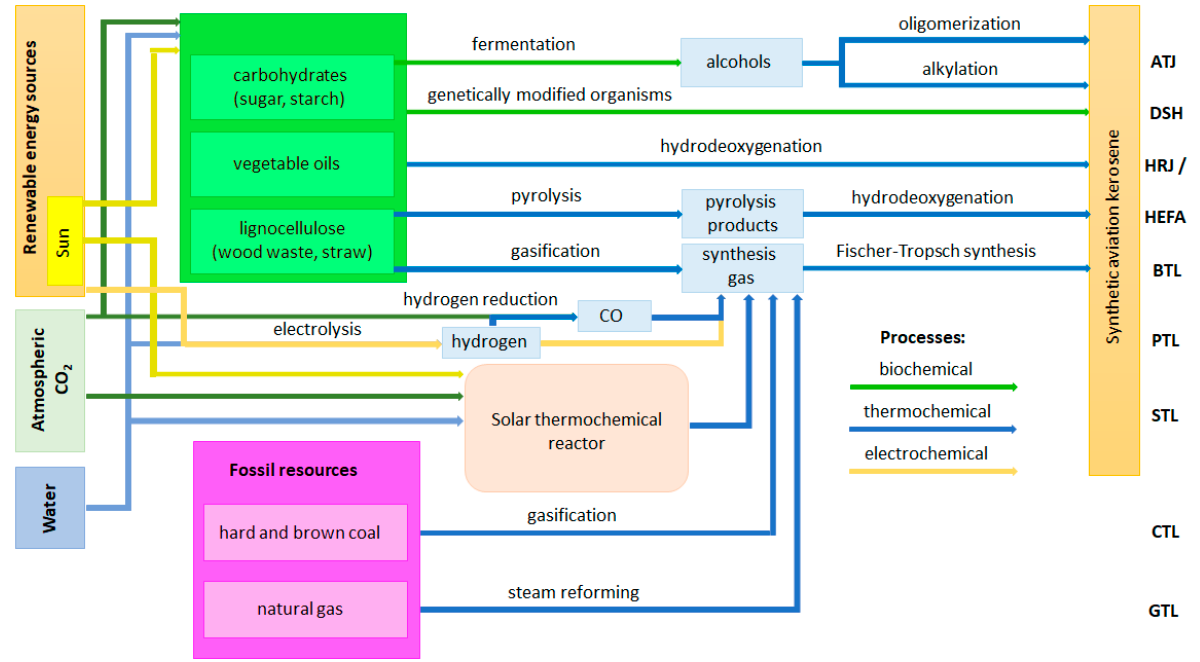
Figure 3. Production of promising alternative fuels.